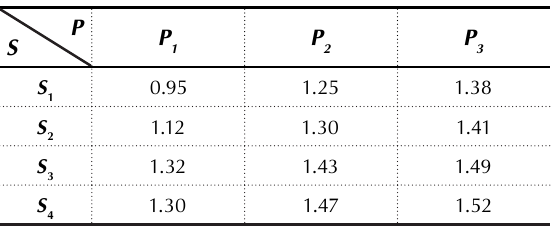
Table 4. IRR – investment rate of return